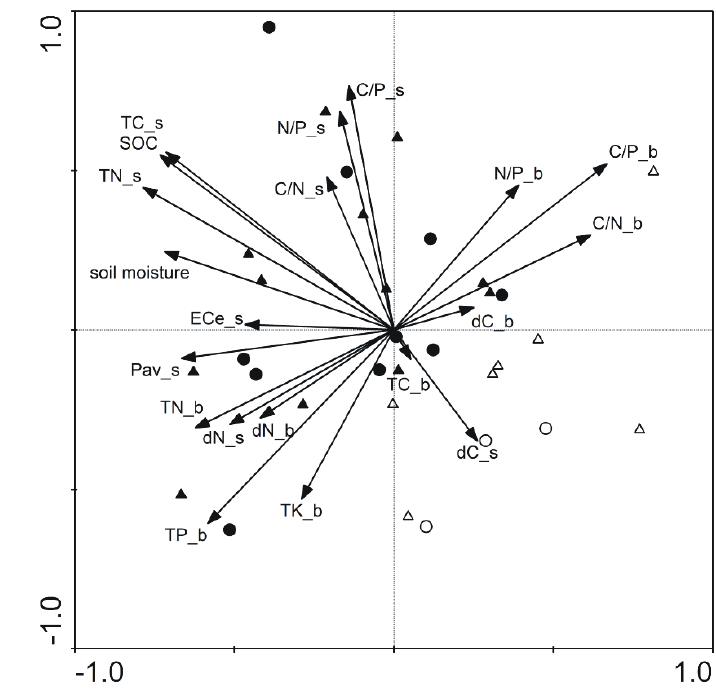
Figure 3. PCA of soil (suffix s) and biomass (suffix b) properties, λ λ = 0.101. Filled circles: Blysmus rufus communities on organic soils (SOC content > 6 %); unfilled circles: 4 Blysmus rufus communities on mineral soils (SOC content < 6 %); filled triangles: Carex communities on organic soils; unfilled triangles: Carex communities on mineral